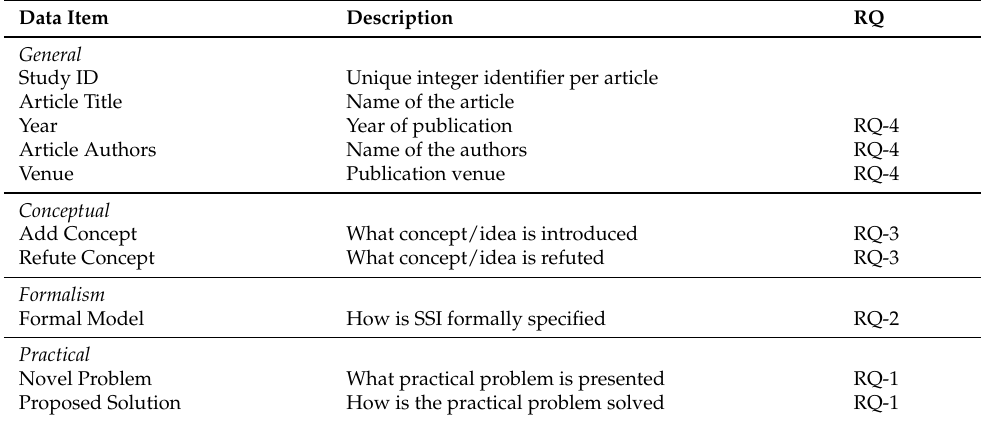
Table 3. Data extraction form adapted from